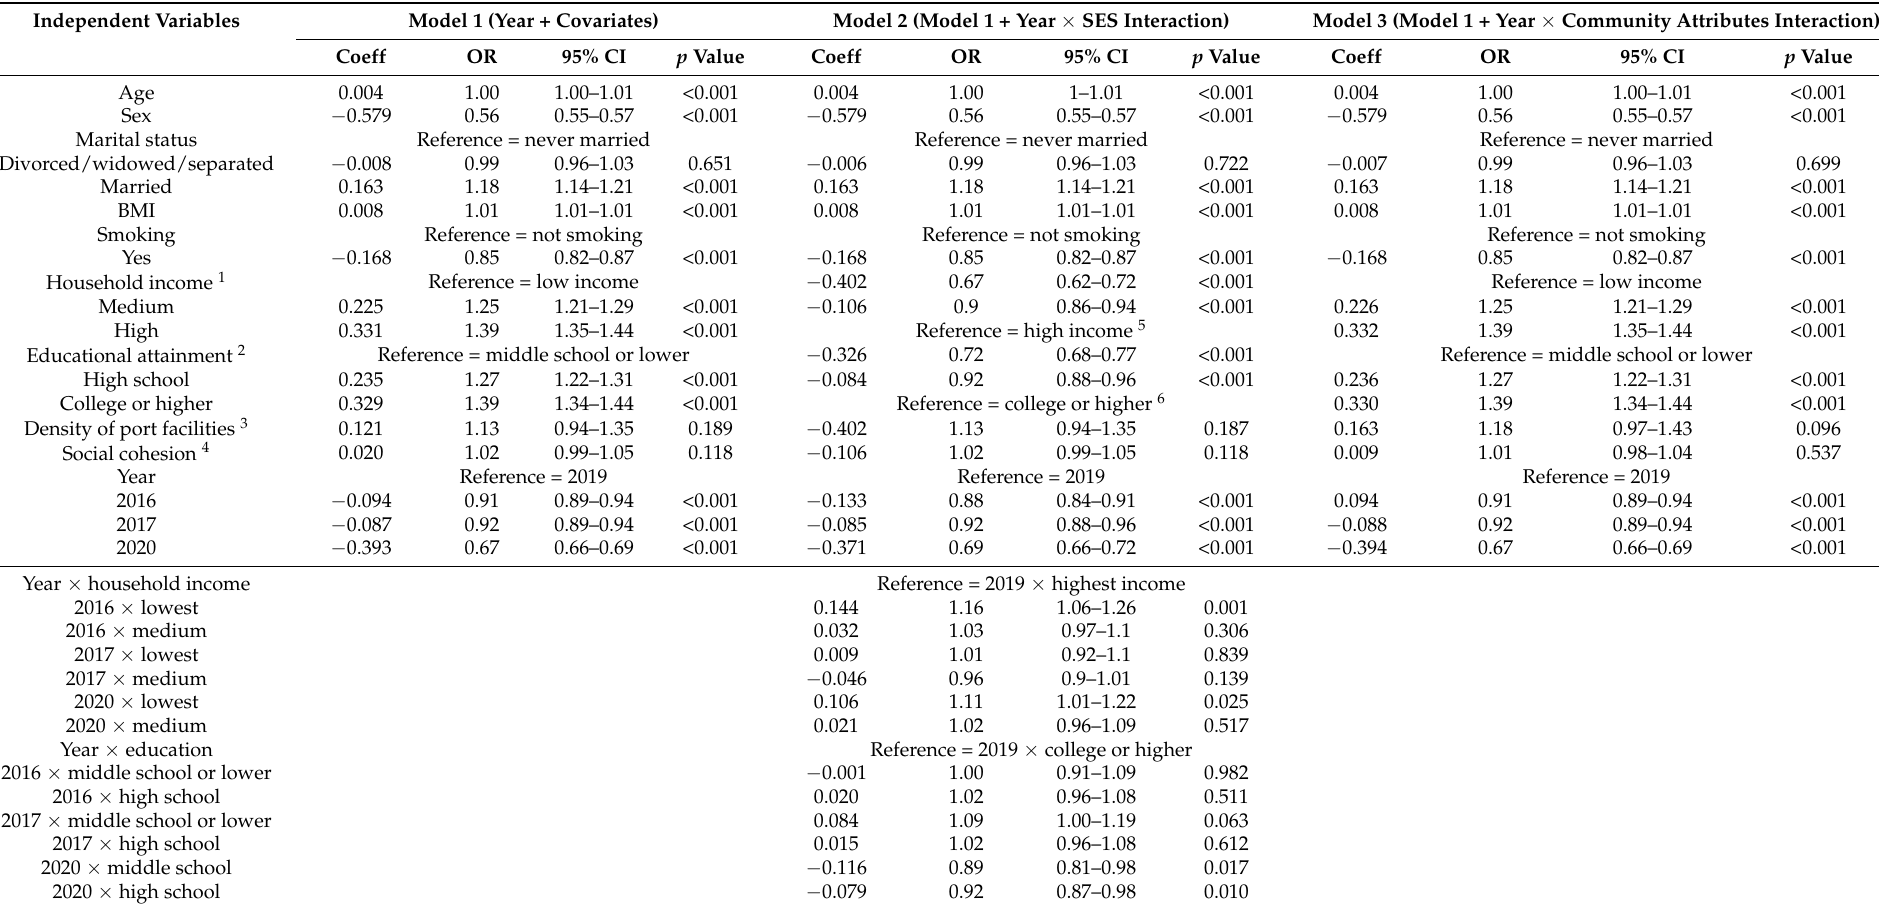
Table 4. Multilevel logistic regression analyses models of demographic characteristics, socioeconomic status, community characteristics, and year associated with aerobic physical activity